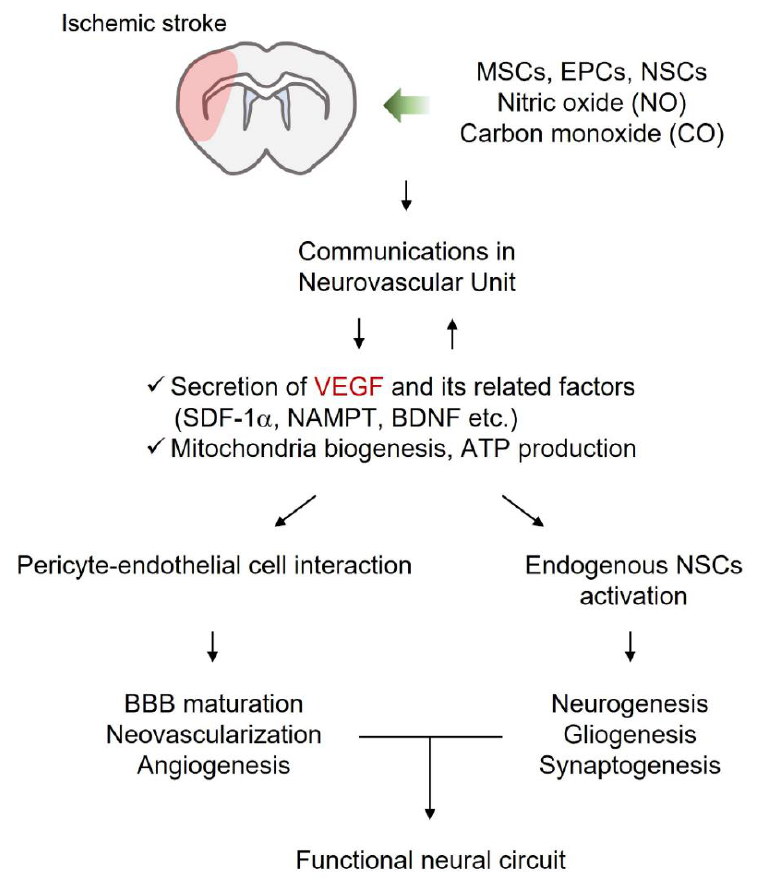
Figure 4. Neuronal growth-promoting environment supported by exogenous stem cells and